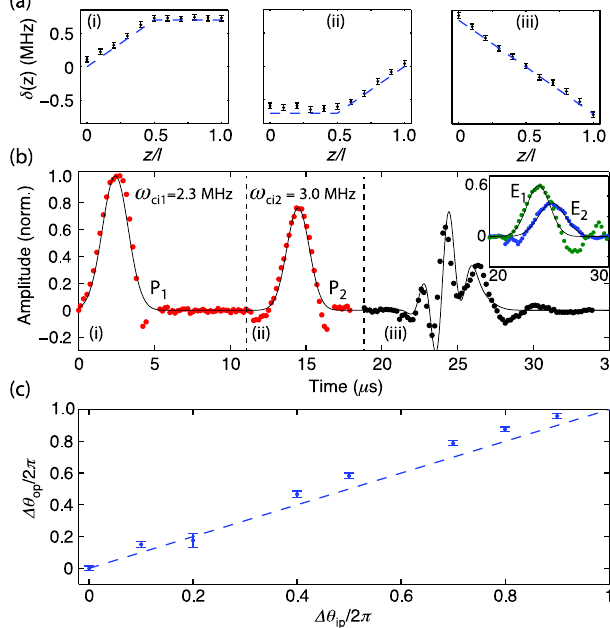
FIG. 6. Interference with pulses of different frequencies. (a) Two-photon detuning (cid:5) as a function of position z along the memory (normalized to length l ) due to (i)–(ii) input gra- dients and (iii) the output gradient corresponding to times FIG. 5. Spectral filtering. (a) Two-photon detuning (cid:5) as a (i)–(iii) in (b). Blue (dashed) lines correspond to the desired function of position z along the memory (normalized to length field, and points correspond to the measured magnetic field. l ) due to gradients (i)–(iii) corresponding to times (i)–(iii) in (b). (Error bars are due to the sensitivity of the Gauss meter.) For traces (a) and (c) blue (dashed) lines correspond to the (b) Interference of two pulses that are initially time separated, desired field, and points correspond to the measured magnetic (i) P 1 and (ii) P 2 , shown in red, which are also separated in field. (Error bars are due to the sensitivity of the Gauss meter.) frequency by 700 kHz. Panel (iii) in (a) shows the superposition (b) Spectral filtering of (i) a Gaussian envelope containing two of the two pulses. The inset in (b) shows the output from the frequency components separated by 700 kHz (red, nondemodu- memory for storage of only a single pulse: P 1 recall ( E 1 , green) lated, scaled by 1 = 2 ) and the demodulated retrieval (blue) of or P 2 recall ( E 2 , blue). Points correspond to demodulated data (ii) higher- and (iii) lower-frequency components averaged over averaged over 100 traces, lines correspond to Gaussian fit to 100 traces. For traces (b) and (d), points correspond to data, lines data, and ! c values correspond to center frequencies of pulses. values correspond to center correspond to fit to data, and ! (c) The change in the relative phase of the fitted interference c frequencies of pulses. (c) Two-photon detuning due to (i) input pulse (cid:2) (cid:7) op as a function of the relative phase of the input pulses (cid:2) (cid:7) and (ii), (iii), and (iv) output gradients corresponding to times ip . Points represent data extracted from the fit (error bars are (i)–(iv) in (d), which shows the conversion from the time to the from standard deviation of 100 traces), and the dashed line frequency domain of (i) a Gaussian pulse with two modulation corresponds to the theoretical sidebands at (cid:8) 700 kHz (red, nondemodulated, scaled by 1 = 2 ), and the demodulated retrieval of (ii) the higher-frequency side- band, (iii) the carrier, and (iv) the lower-frequency sideband averaged over 100 traces (blue).